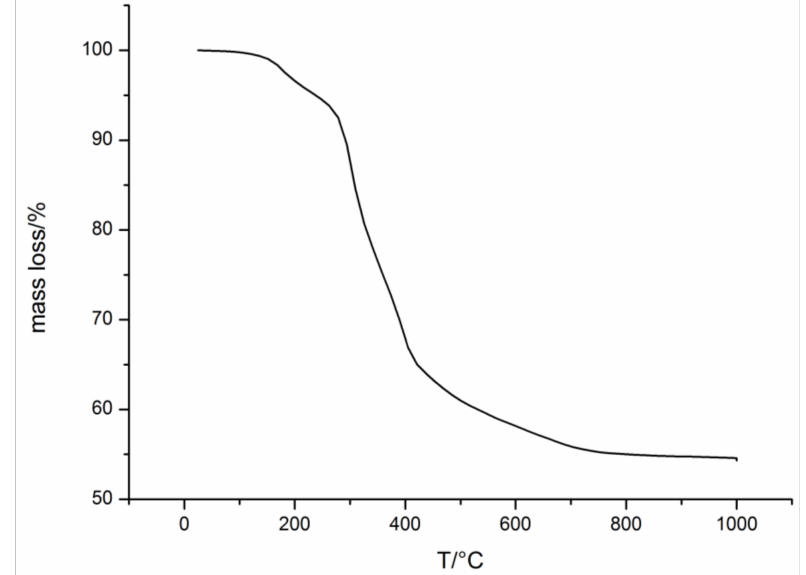
Figure 10. TEM image of hybrid core–shell particles consisting of inimer-containing particles featuring a Durazane1800 shell.